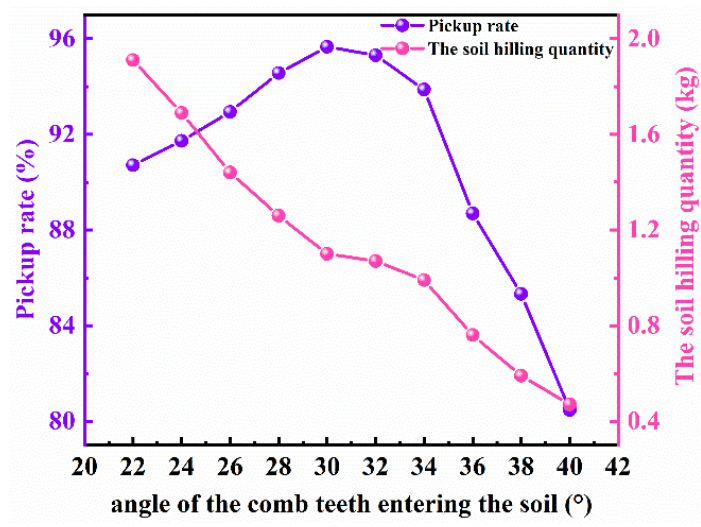
Figure 9. Variation curve of test index with the ACT.